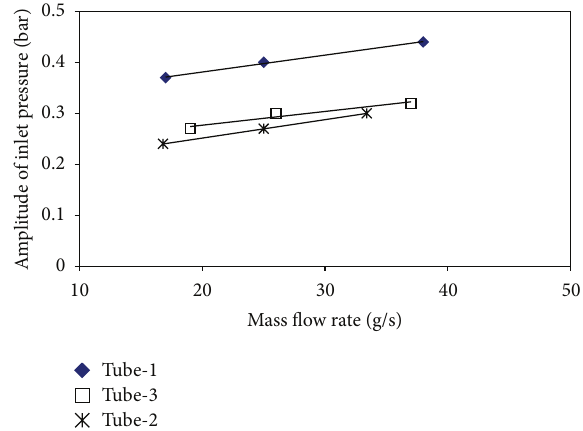
F 18: e variations in the amplitudes with the mass �ow rate for all tubes (d. w.